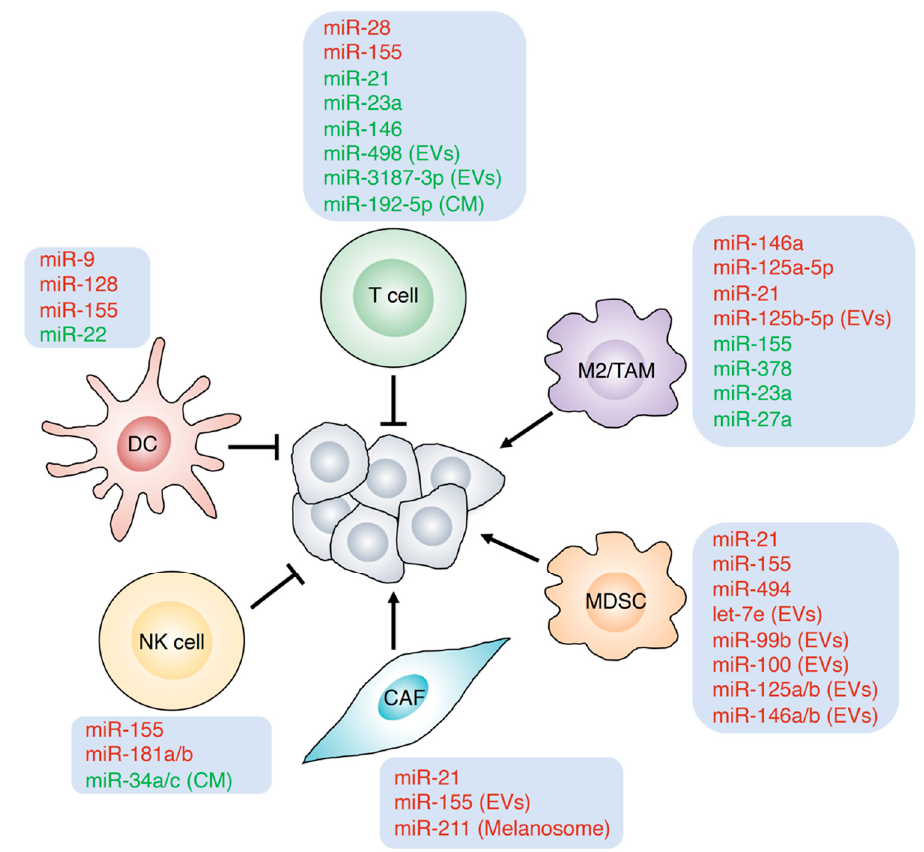
Figure 2. Regulator of miRNAs in microenvironment. miRNAs modulate the functions of immune cells in the tumor microenvironment. T cells, DCs, and NK cells suppress the progression of cancer, while MDSCs, M2/TAMs, and CAFs support the tumor development. M2/TAM: M2 macro- phage/tumor-associated macrophage; MDSC: myeloid-derived suppressor cell; CAF: cancer-associ- ated fibroblast; NK cell: natural killer cell; and DC: dendritic cell. Melanoma cells secrete miRNAs through extracellular vesicles (EVs) or conditioned medium (CM) to communicate and regulate the immune cells. miRNAs induce (red) or reduce (green) the functions of the immune cells included.